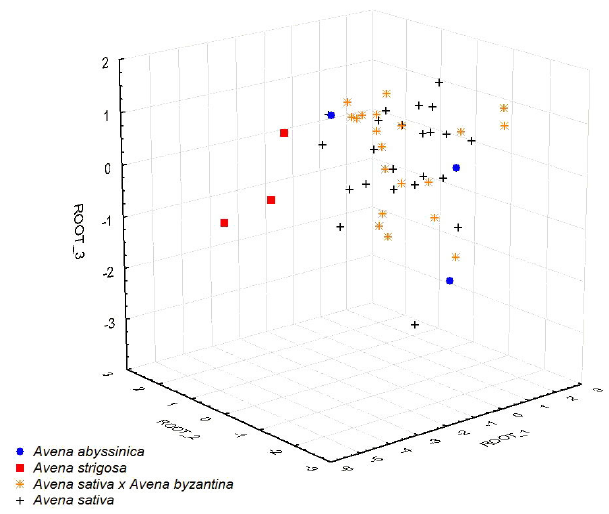
Figure 2. Distribution of the grain of Avena L. species accessions from the VIR collection in the space of three canonical axes.